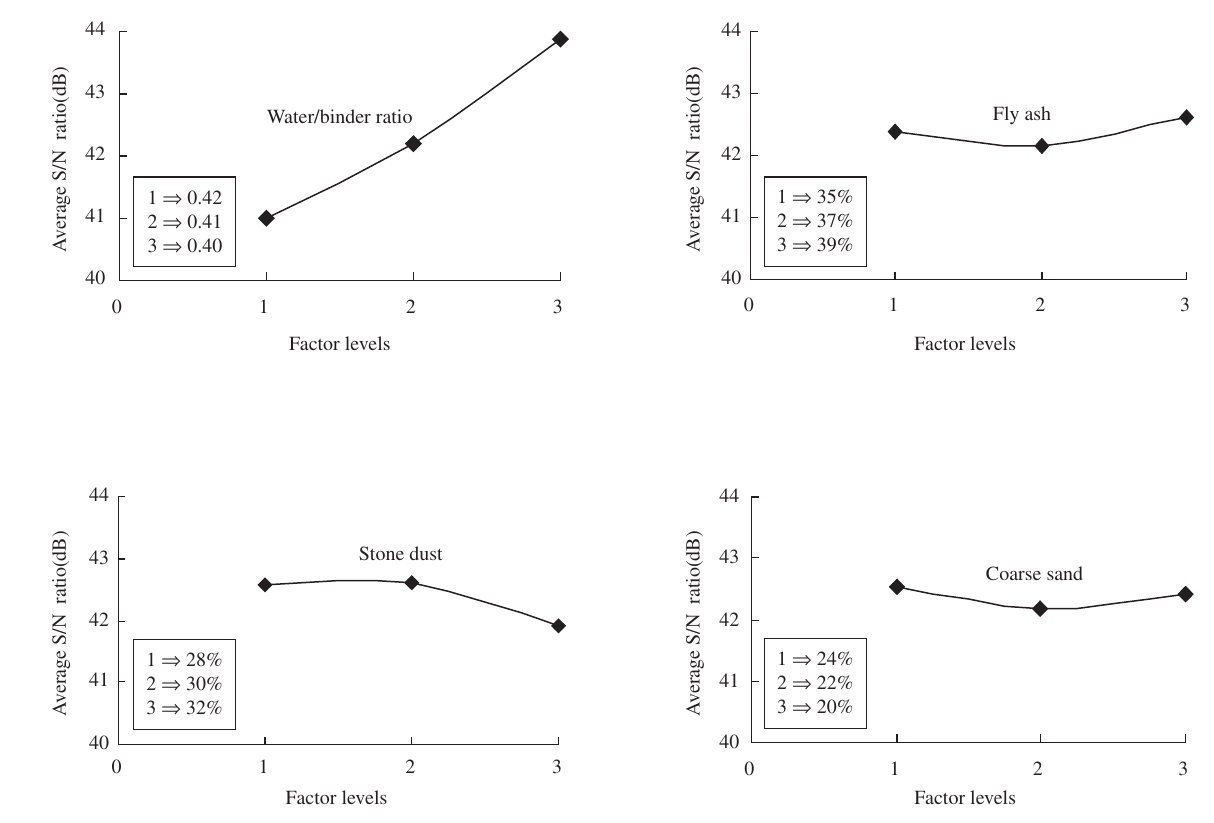
Figure 2. Effects of process parameters on average S/N